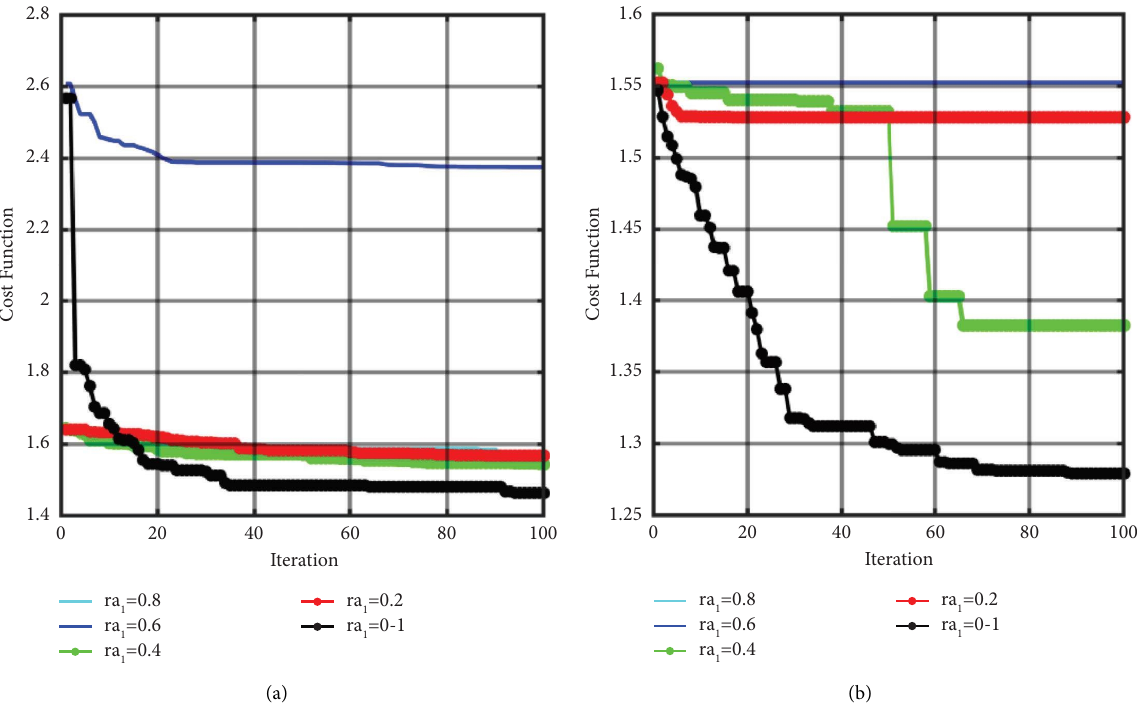
Figure 8: Convergence analysis of the proposed POCSO algorithm at various arbitrary values for (a) IEEE-14 bus system and (b) IEEE-30 bus